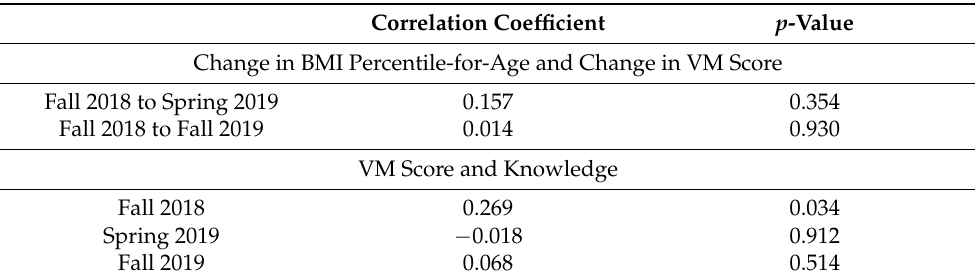
Table 3. Correlations between change in BMI percentile-for-age and change in VM score and VM score and